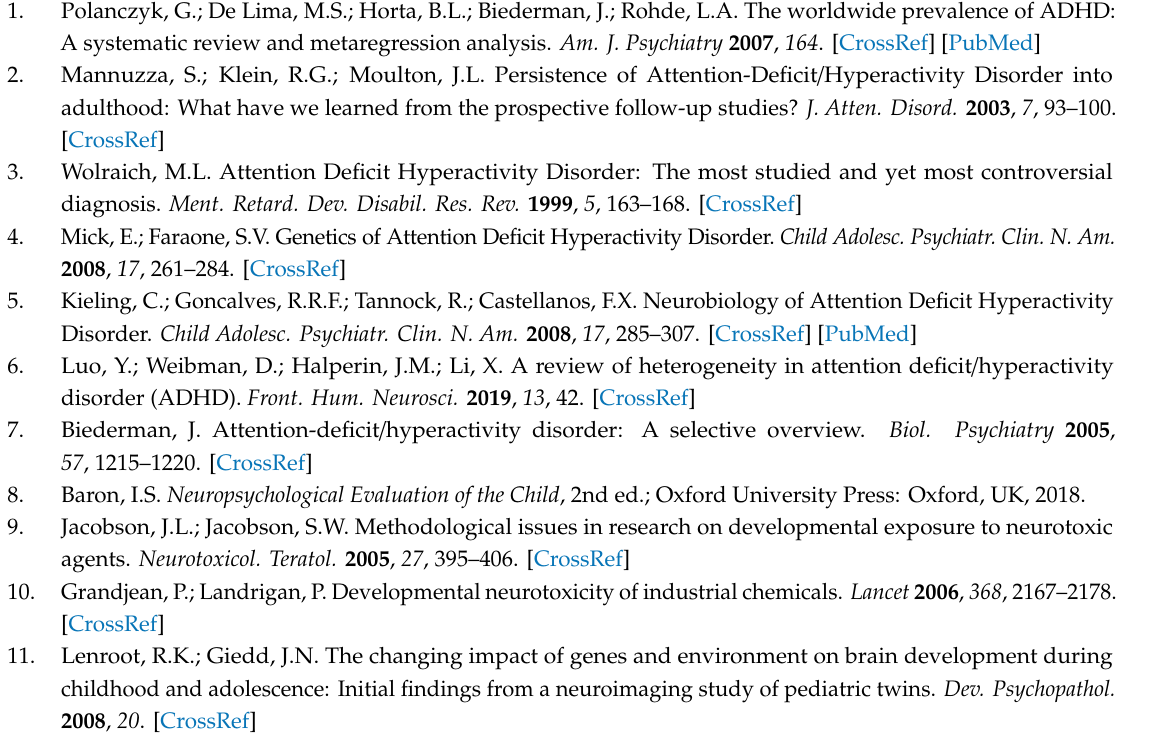
Table S1: Descriptive characteristics of the study sample and the excluded